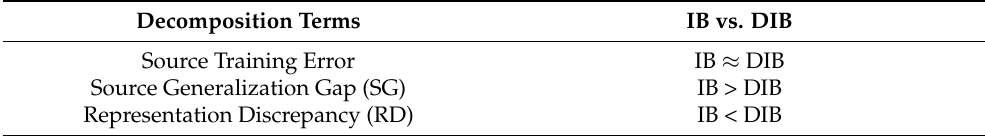
Table 1. A comparison of IB and